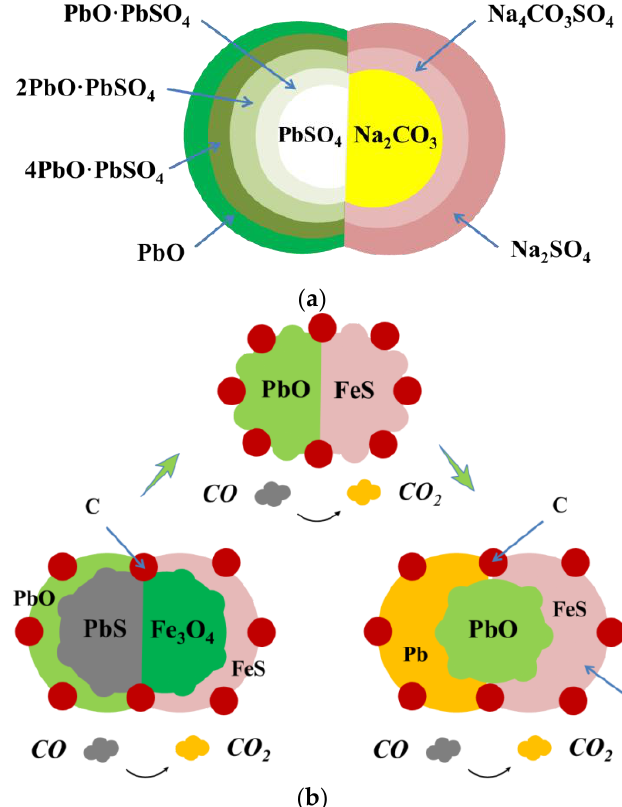
Figure 3. Schematic of ( a ) the multistage process between PbSO 4 and Na 2 CO 3 and ( b ) lead extraction reactions between PbS and Fe 3 O 4 .